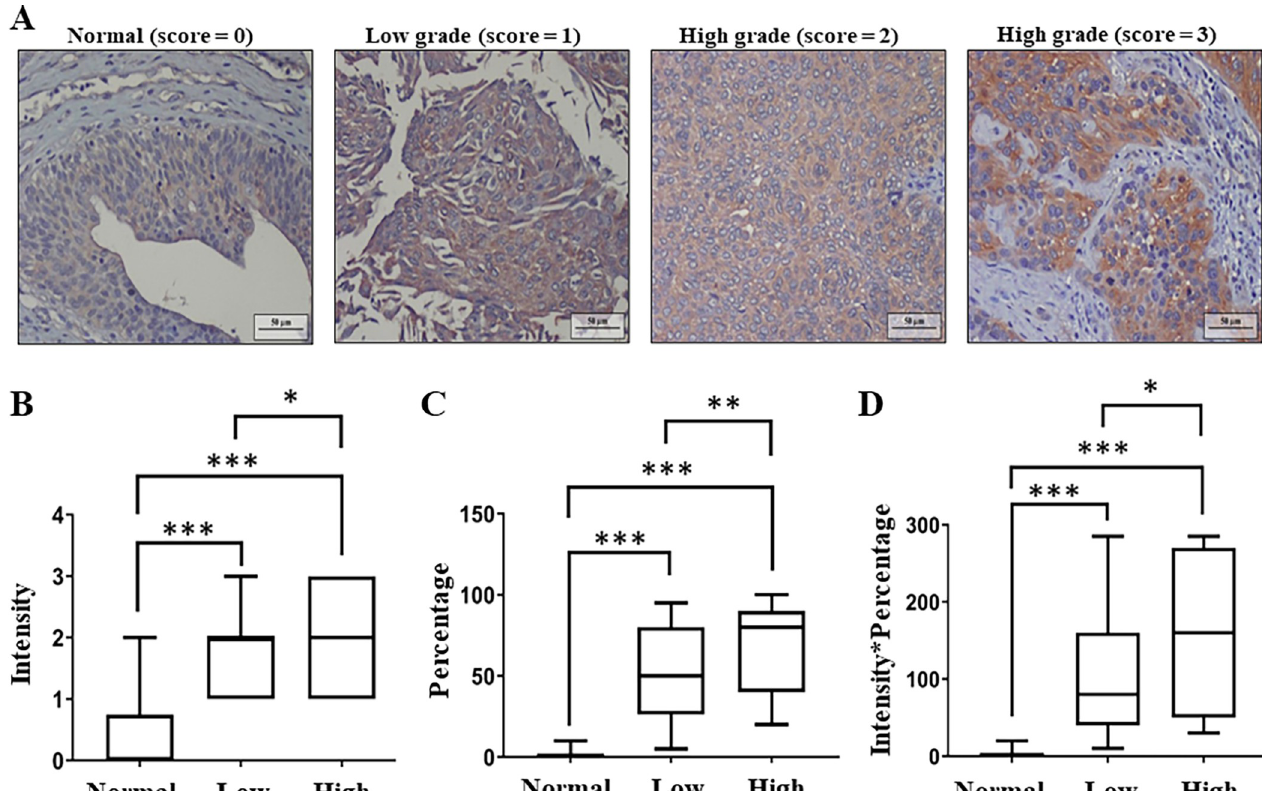
Fig 1. Evaluation of the clinical significance of CDCP1 by using tissue arrays. (A) Immunohistochemical staining with antibody against CDCP1 was performed to evaluate CDCP1 expression on the tissue arrays of UC. IHC tissues were observed and photographed at 40X magnification with an optical microscope (Olympus, Tokyo, Japan). Images were representative of negative, weak, moderate and strong CDCP1 staining at specimens of the normal, low grade, and high grade. (B) The intensity of CDCP1 expression was correlated with tumor grade. (C) The staining percentage of CDCP1 was correlated with tumor grade. (D) The product of the intensity and staining percentage of CDCP1 was correlated with tumor grade. Scale bar indicates 50 μ m. Statistical analyses were evaluated by one-way ANOVA with Tukey’s multiple comparisons test. The results were presented as mean ± SD (normal n = 16; low grade n = 76; high grade n = 57, � p < 0.05, �� p < 0.01, ��� p <